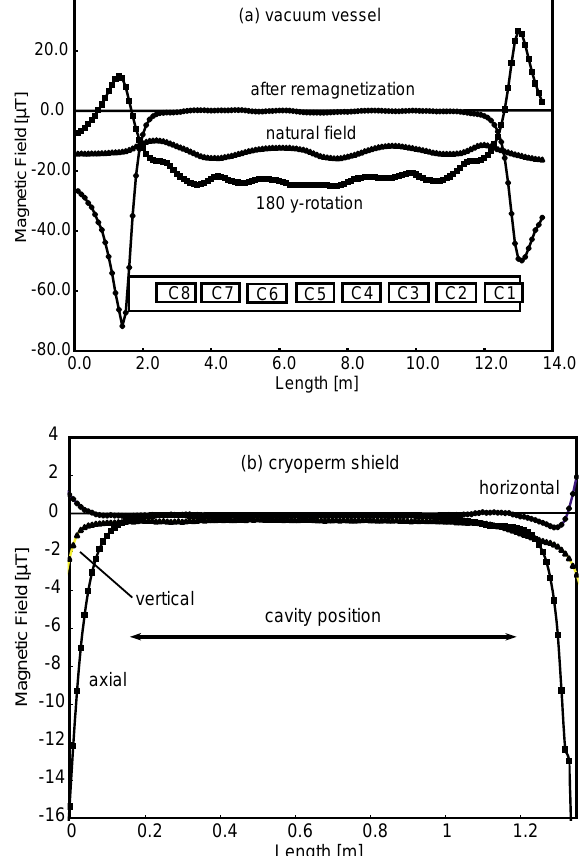
FIG. 8. Shielding of the Earth’s magnetic field. (a) Shielding of an axial component by the steel vacuum vessel of the cryo- module. Also shown is the arrangement of the cavity string in the vessel. (b) Shielding of the axial, horizontal, and vertical field components by the cryoperm cylinder surrounding the cav- ity (measured without vacuum